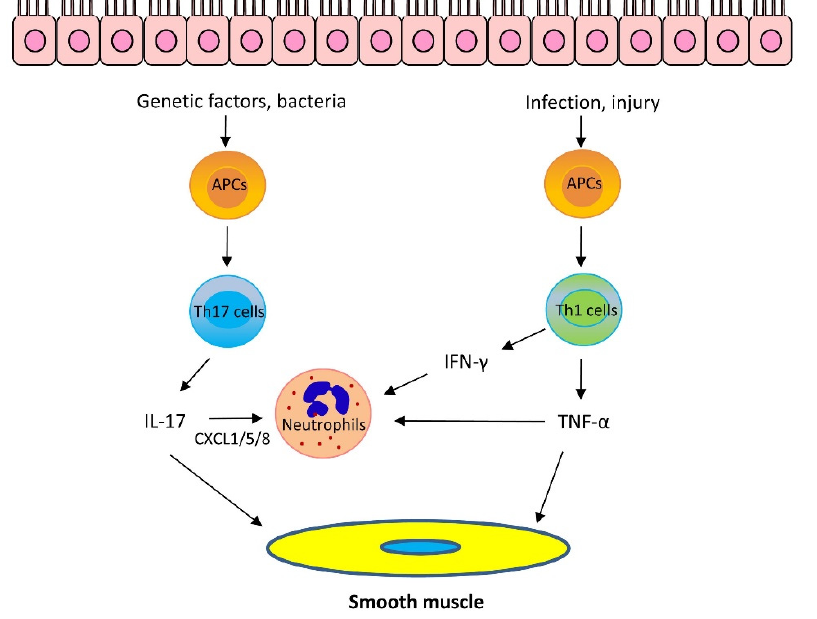
Figure 2. Mechanism of Th2-low asthma. ( A ) Th17 cytokines. Bacteria promote Th17 cell differenti- ation via antigen-presenting cells (APCs). Variants in the IL-17 pathway genes also contribute to IL- 17 upregulation. IL-17 can stimulate epithelial cells and fibroblasts to release neutrophil chemoat- tractants CXCL1/5/8 which recruit neutrophils to the lungs. Furthermore, IL-17A enhances airway smooth muscle contraction, migration, and proliferation, which facilitates AHR and airway remod- eling, ( B ) Th1 cytokines. Infection and epithelial injury promote Th1 cell maturation and secrete Th1 cytokines, including TNF- α and IFN- γ . TNF- α synergizes with IL-17 cytokines to promote neutro- phil recruitment. Furthermore, TNF- α enhances airway smooth muscle contraction. IFN- γ and TNF- α upregulate Ca 2+ signaling in airway smooth muscle and induces AHR. In addition, IFN- γ pro- motes neutrophil recruitment in the presence of IL-17 cytokines.